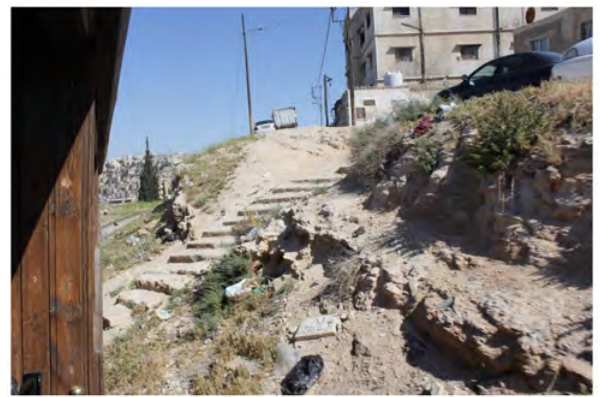
Figure 7. Examples of Fadlih ’s, Nutfih ’s and Arasah ’s 3. Source: Author (2015)